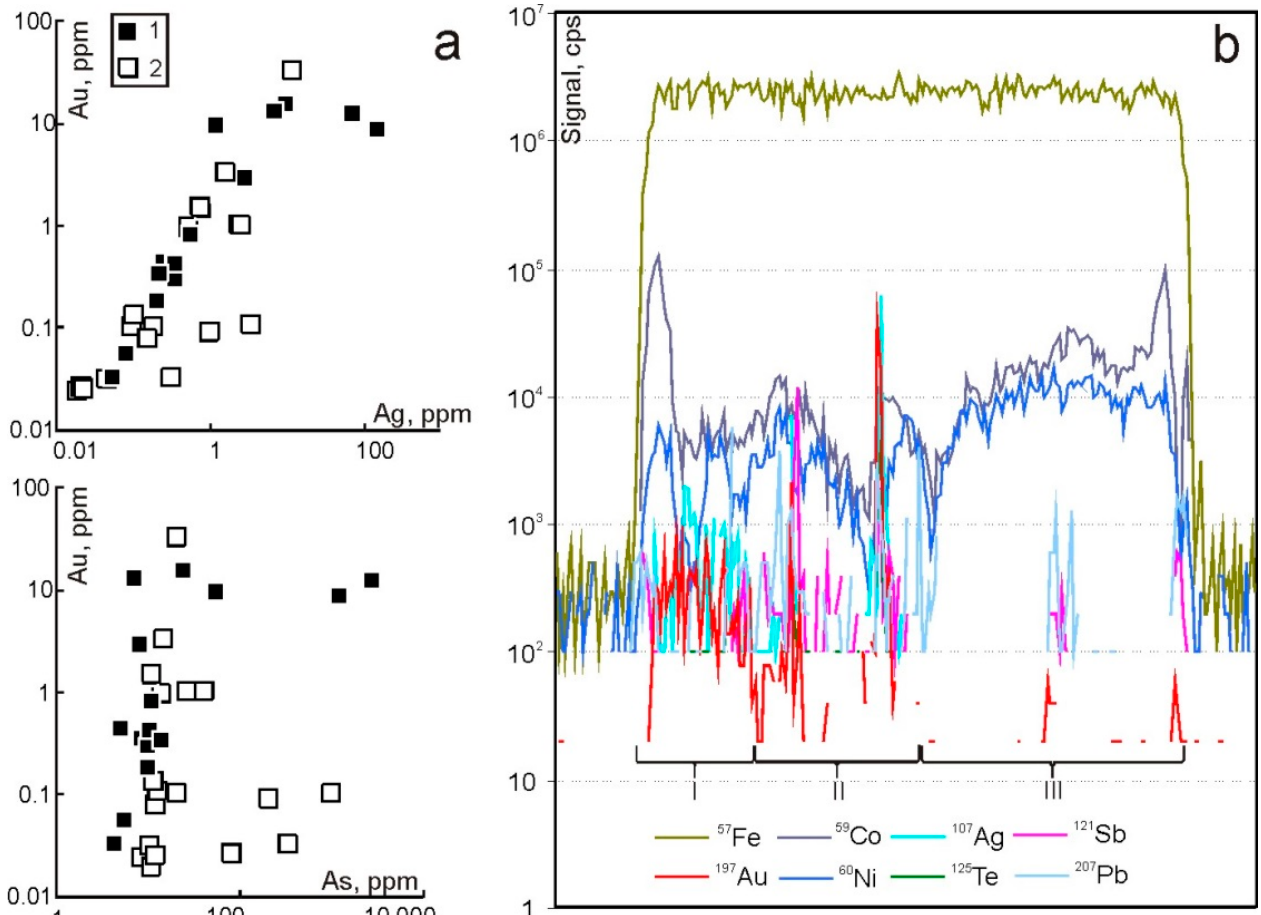
Figure 15. Trace element distribution in pyrite of the Svetlinsk gold deposit according to LA-ICPMS analyses. ( a ) Correlation of Au, Ag and As contents in the disseminated (1) and vein (2) pyrite, ( b ) nonuniform Au distribution in the pyrite crystal according to ablation profile data: I—zone with uniform distribution, probably indicating the entry of Au into the pyrite structure, II—zone with inclusions of Au-Ag-Sb-Te phases and III—zone with gold content below the detection limit.